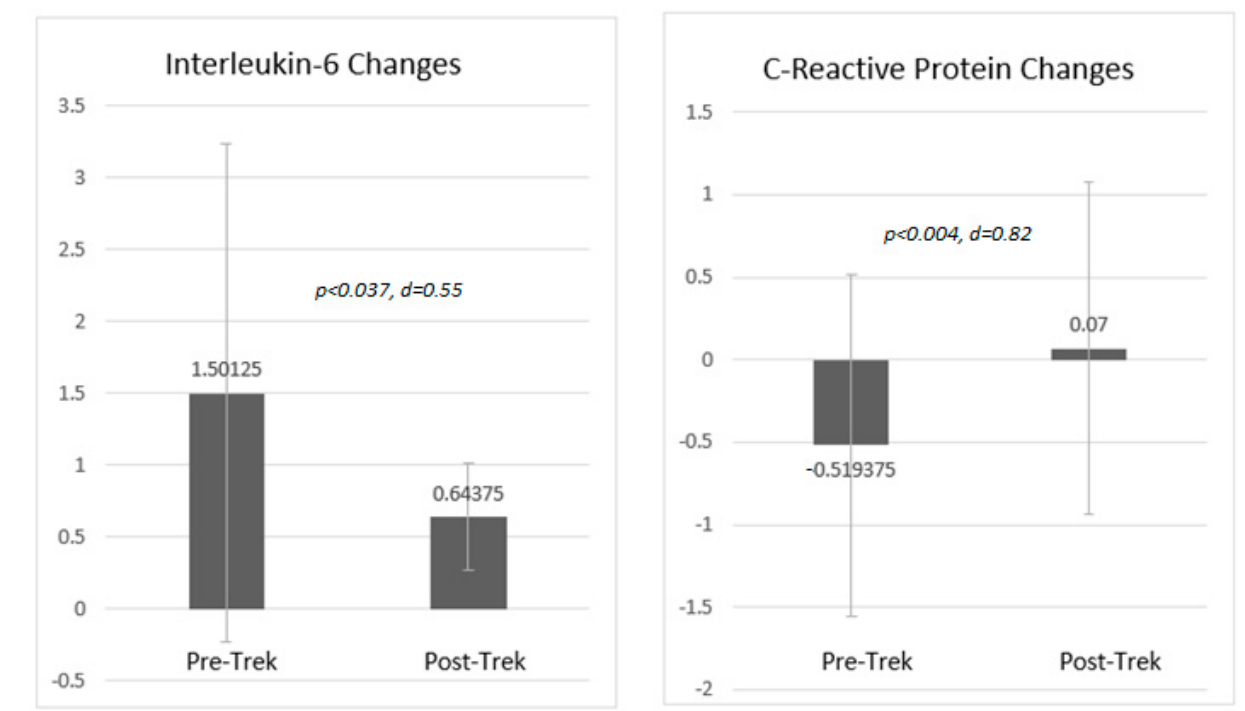
Figure 3. Pre-Post Changes in Interleukin-6 and C-Reactive Protein among Survivors ( n = 16), 2016 Note: Values reflect Figure 3. Pre ‐ Post Changes in Interleukin ‐ 6 and C ‐ Reactive Protein among Survivors ( n = 16), 2016 Note: Values reflect log ‐ transformed estimates. log-transformed